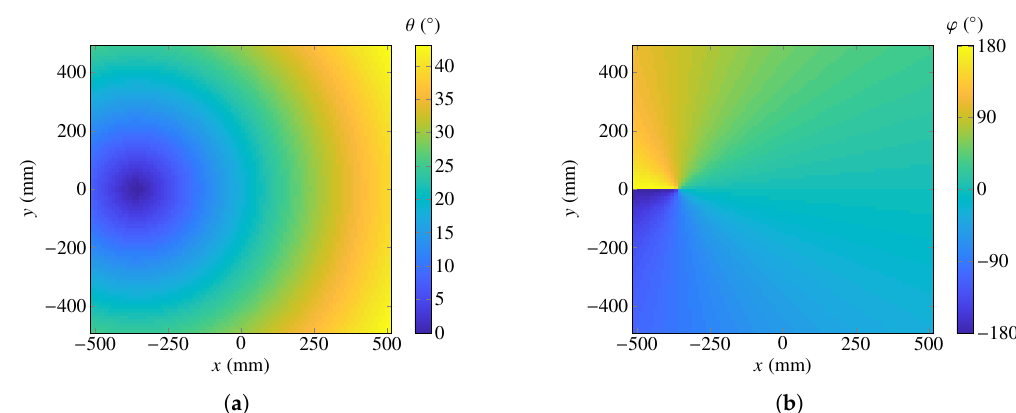
Figure 2. Angle of incidence in degrees seen from each reflectarray element of an impinging wave coming from the feed: ( a ) θ ; and ( b ) ϕ